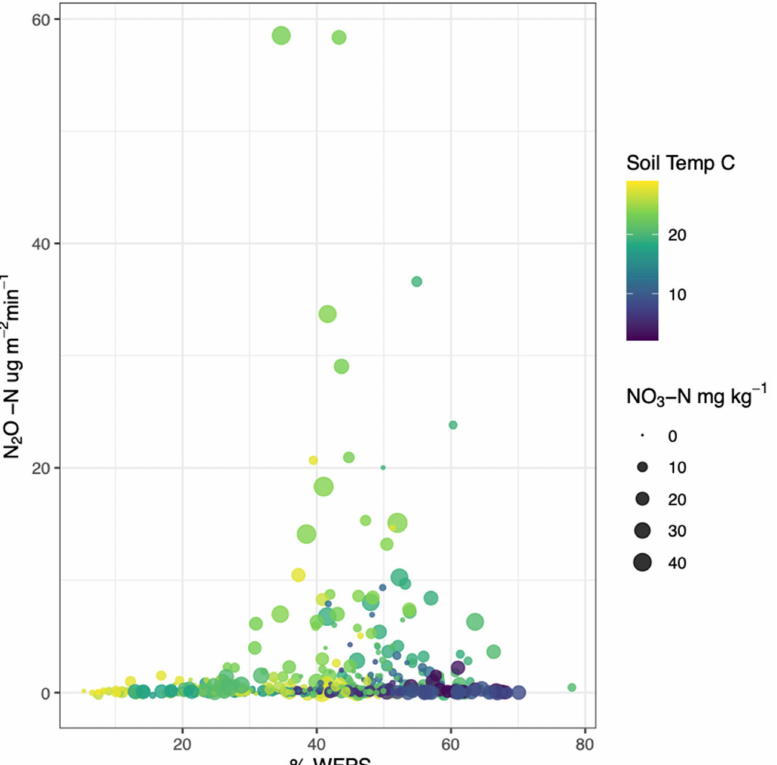
Figure 6. Bubble scatter plot showing the relationship between N 2 O fluxes (y-axis), WFPS (x-axis), soil NO 3 -N content (circle size), and soil temperature (color